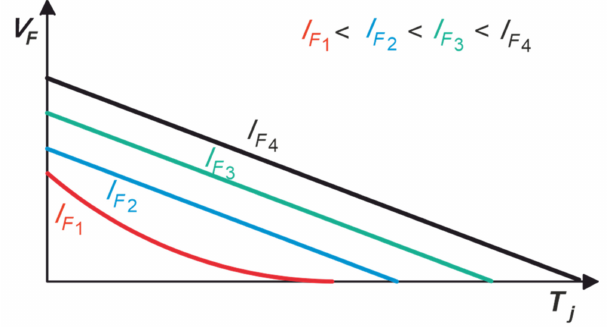
Figure 4. Dependence of forward voltage V F on the die temperature T j for a constant I F